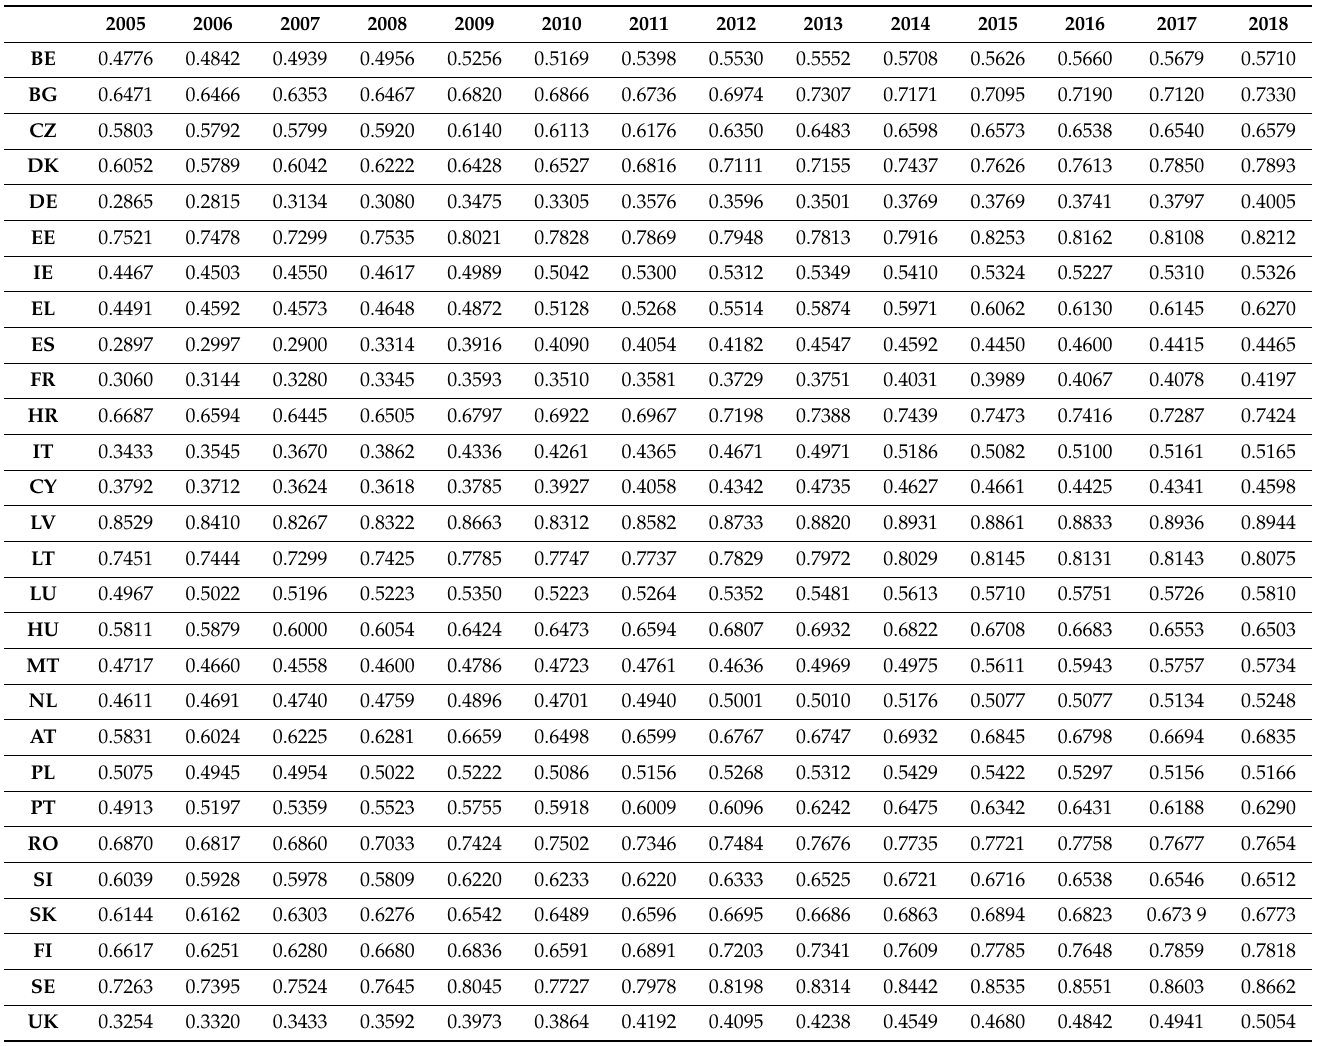
Table 4. Synthetic